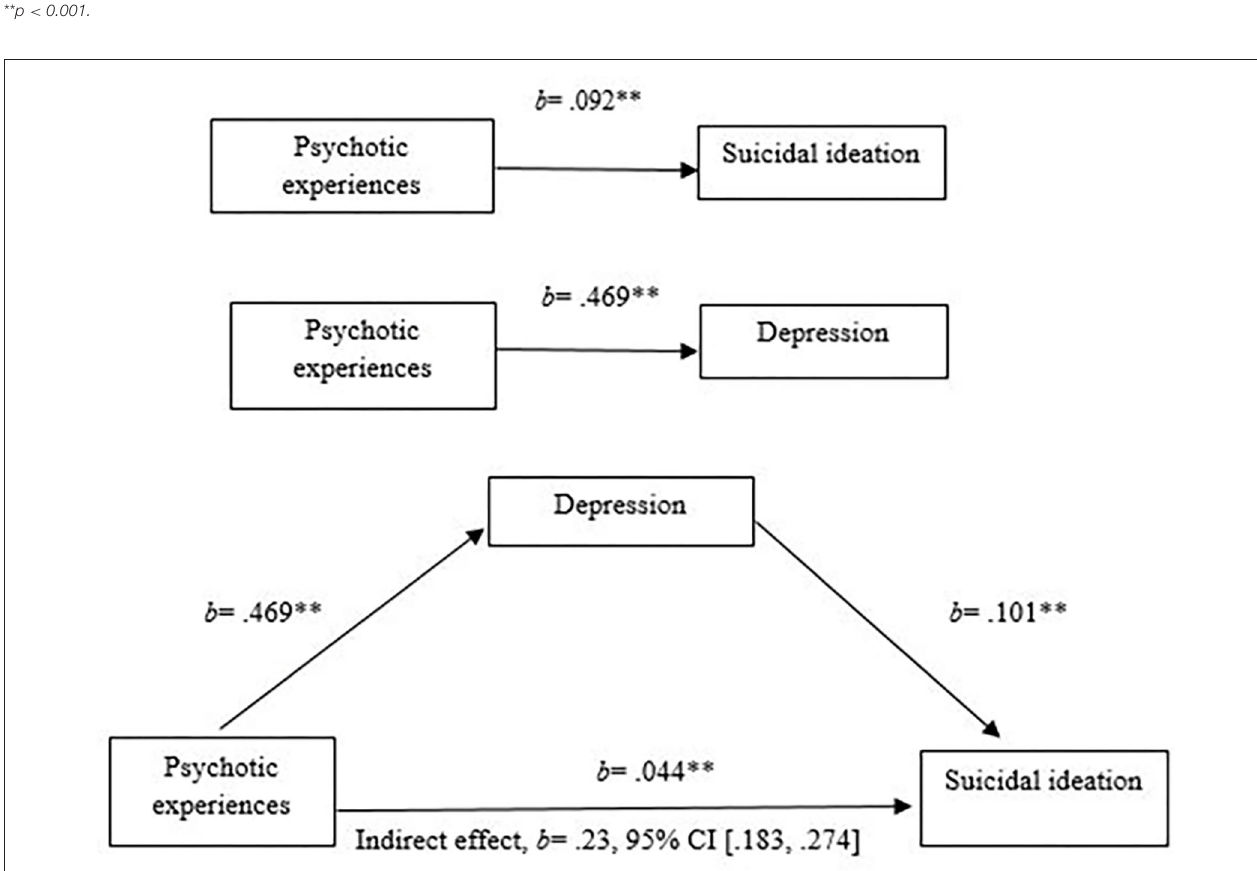
FIGURE 1 | Mediation analysis of the relationship of psychotic experiences and suicidal ideation mediated by depressive